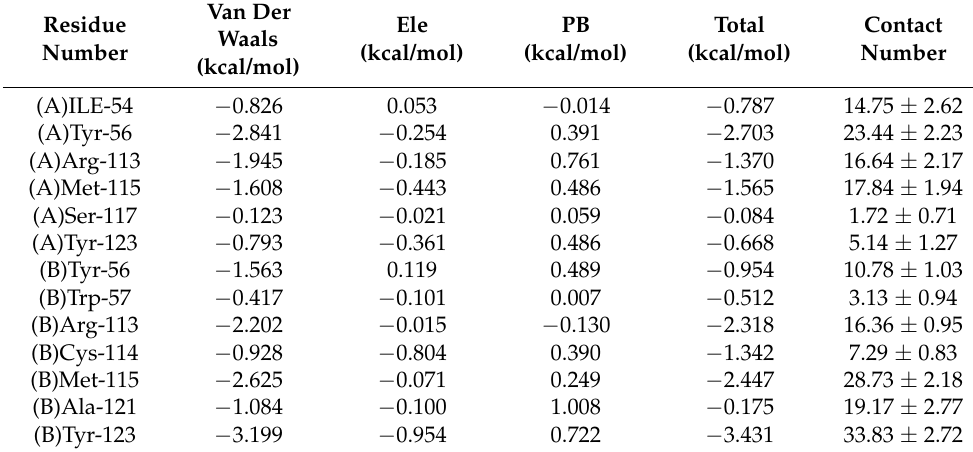
Table 4. Zucapsaicin per-residue energy decomposition.